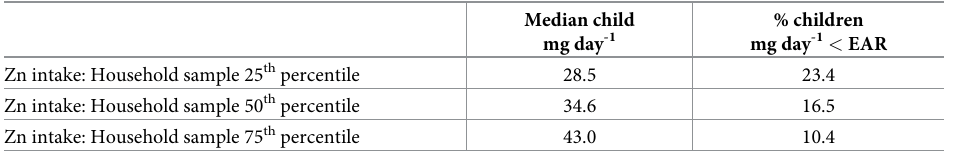
Table 5. Prevalence of inadequate dietary Zn intake by household concentration